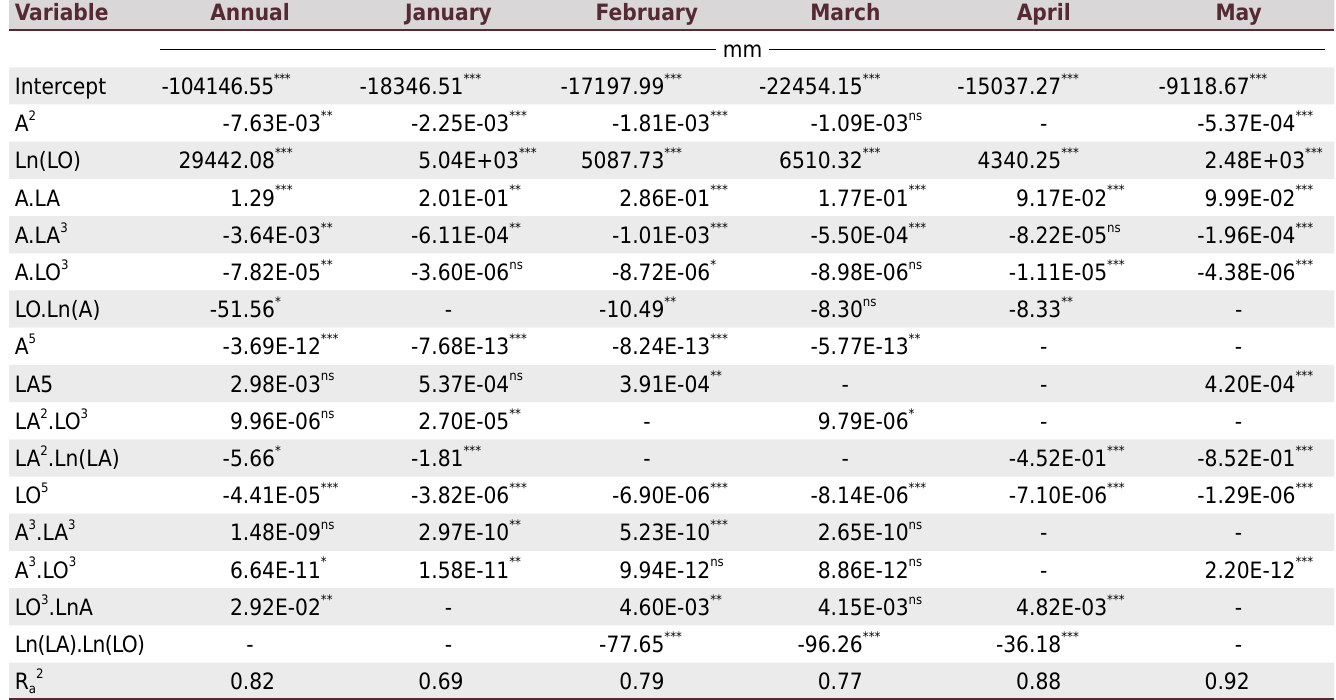
Table 2. Fitted statistical models for rainfall (mean annual, January, February, March, April, and May)